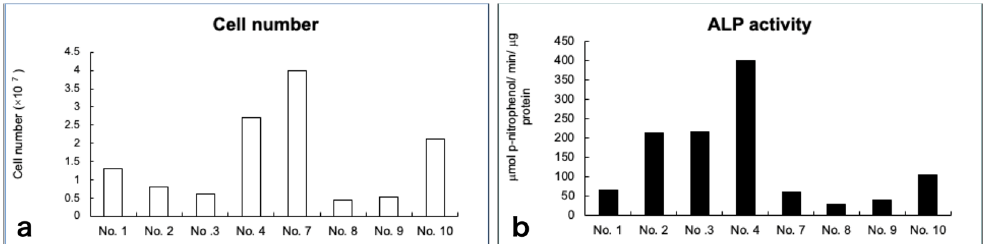
Figure 2 . Total cell number ( a ) and alkaline phosphatase (ALP) activity ( b ) of the cultured cells at harvest before transplantation. ALP activity was expressed as µmol p-nitrophenol/min/µg protein.